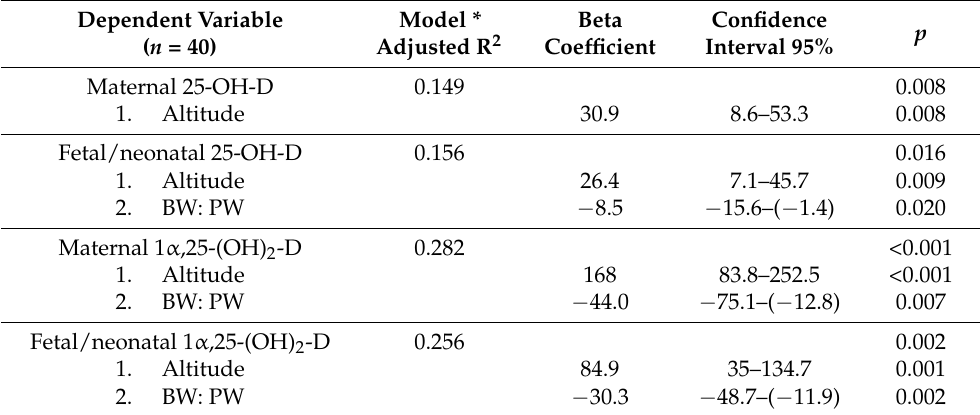
Table 2. Demographic and clinical determinants of vitamin D levels in Bolivian